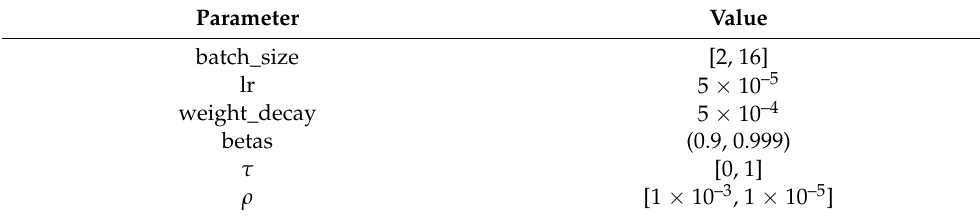
Table 1. DCNG parameter settings.